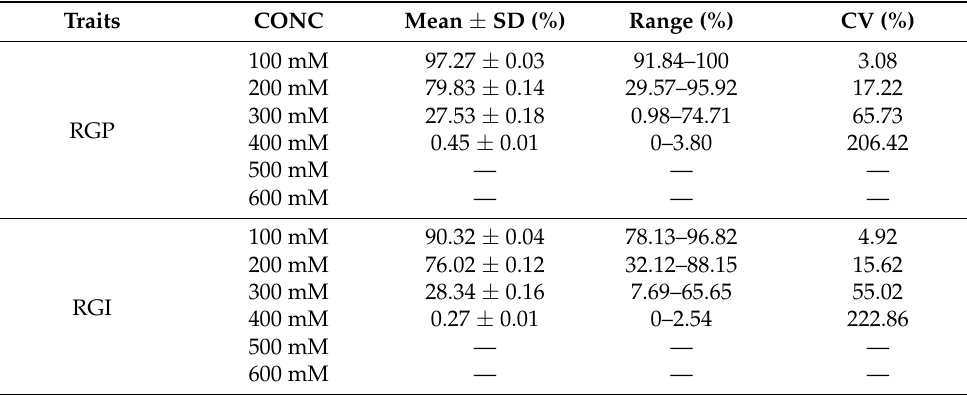
Table 1. Statistical analysis of RGP and RGI of 22 representative rice accessions. Traits